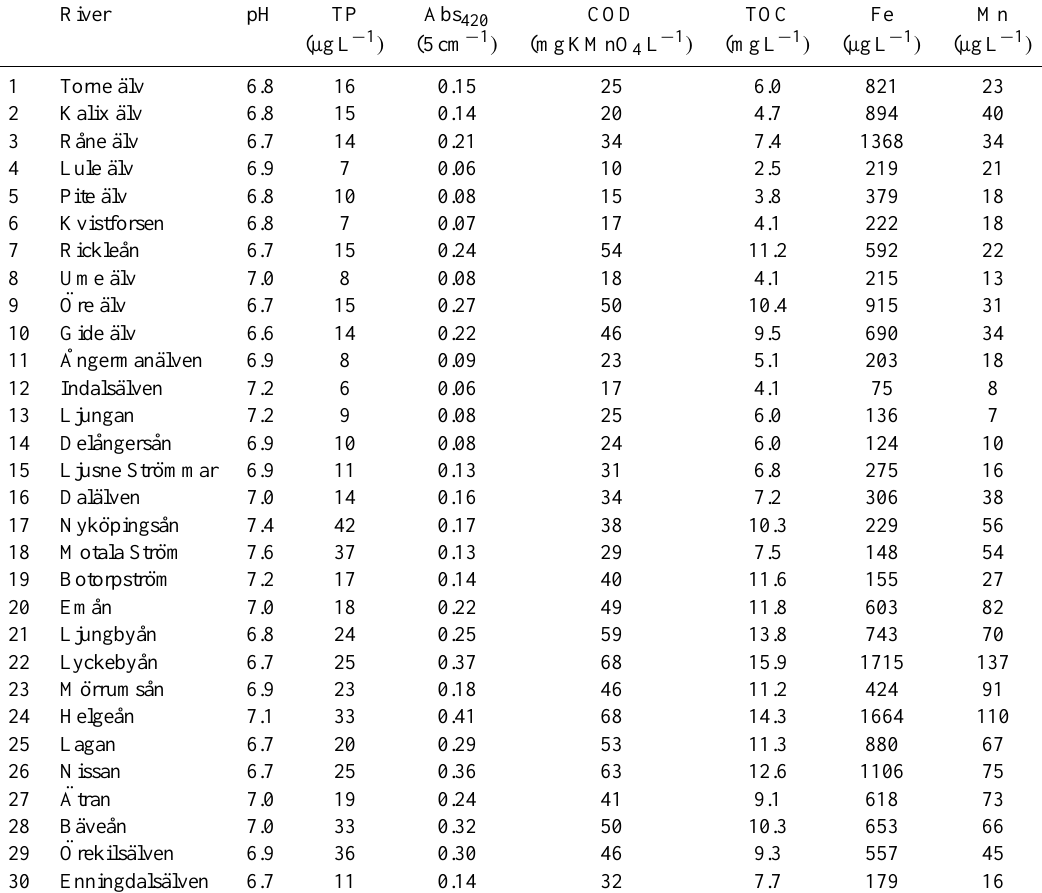
Table 1. Median values of pH, TP, Abs 420 , COD, TOC, Fe and Mn in the 30 Swedish rivers between 1987 and